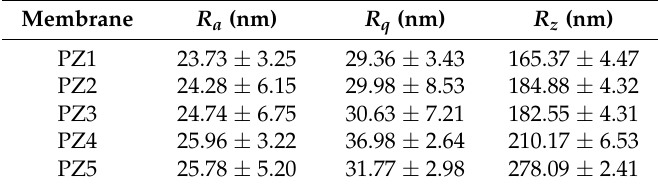
Figure 2. The atomic force microscope (AFM) image of surface roughness of membrane ( A ) PZ1, ( B ) PZ2, ( C ) PZ3, ( D ) PZ4 and ( E ) PZ5. Table 3. The statistical analysis of membrane roughness for membrane PZ1 to PZ5.